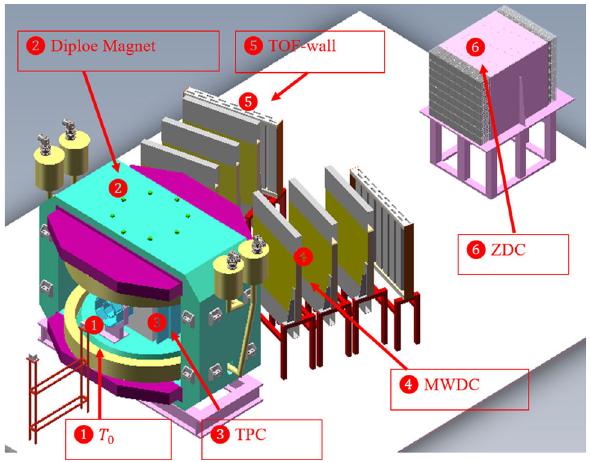
Fig. 1 Schematic layout of the CEE detector system, taken from Ref. [13]